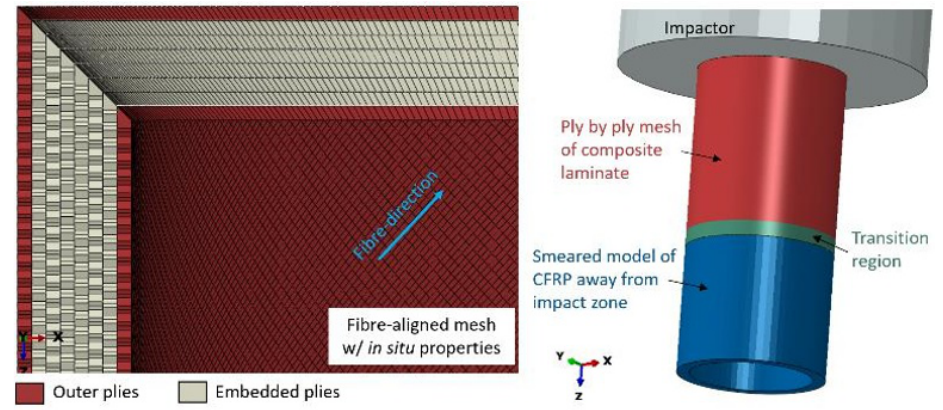
Fig. 3 . Meshing strategy and fibre-aligned mesh of the composite crush